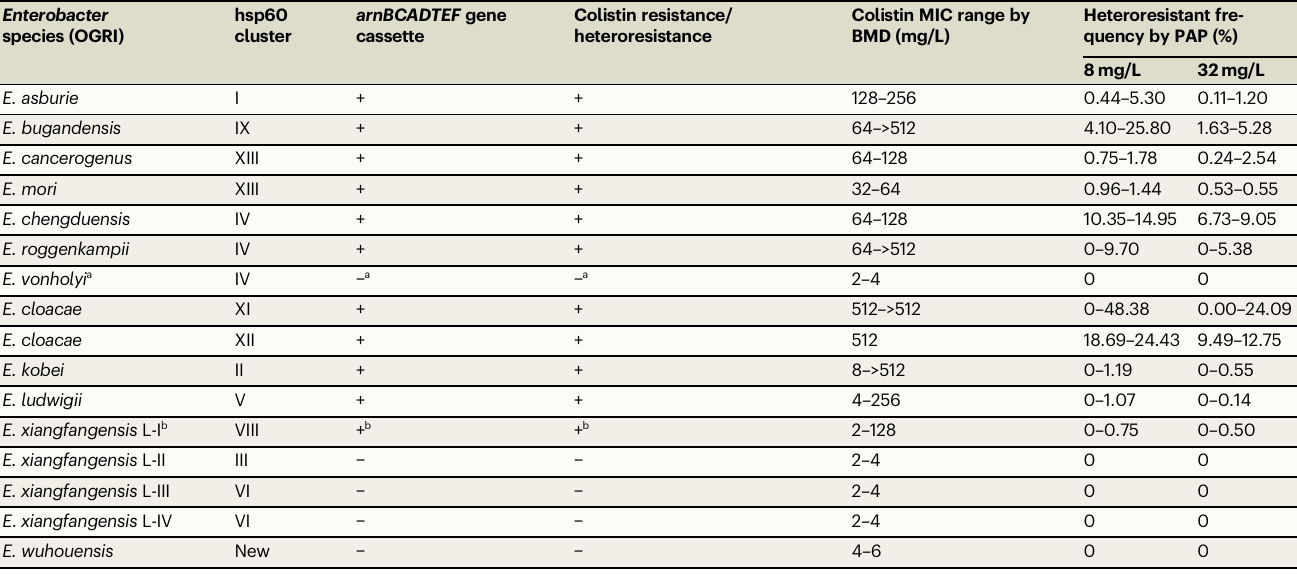
Table 1 | Colistin resistance and heteroresistance of the Enterobacter species Enterobacter hsp60 species (OGRI)